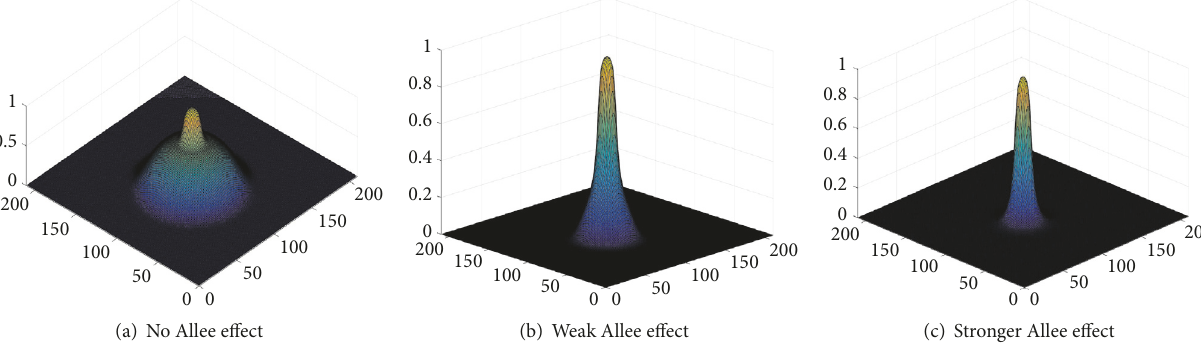
Figure 9: Density of necrotic cells without Allee effect, with weak Allee effect ( 𝑚 = 0.4 ), and with stronger Allee effect ( 𝑚 = 0.1 ). 𝑡 = 20 .